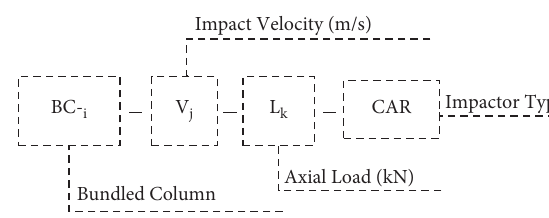
Figure 2: Nomenclature of study